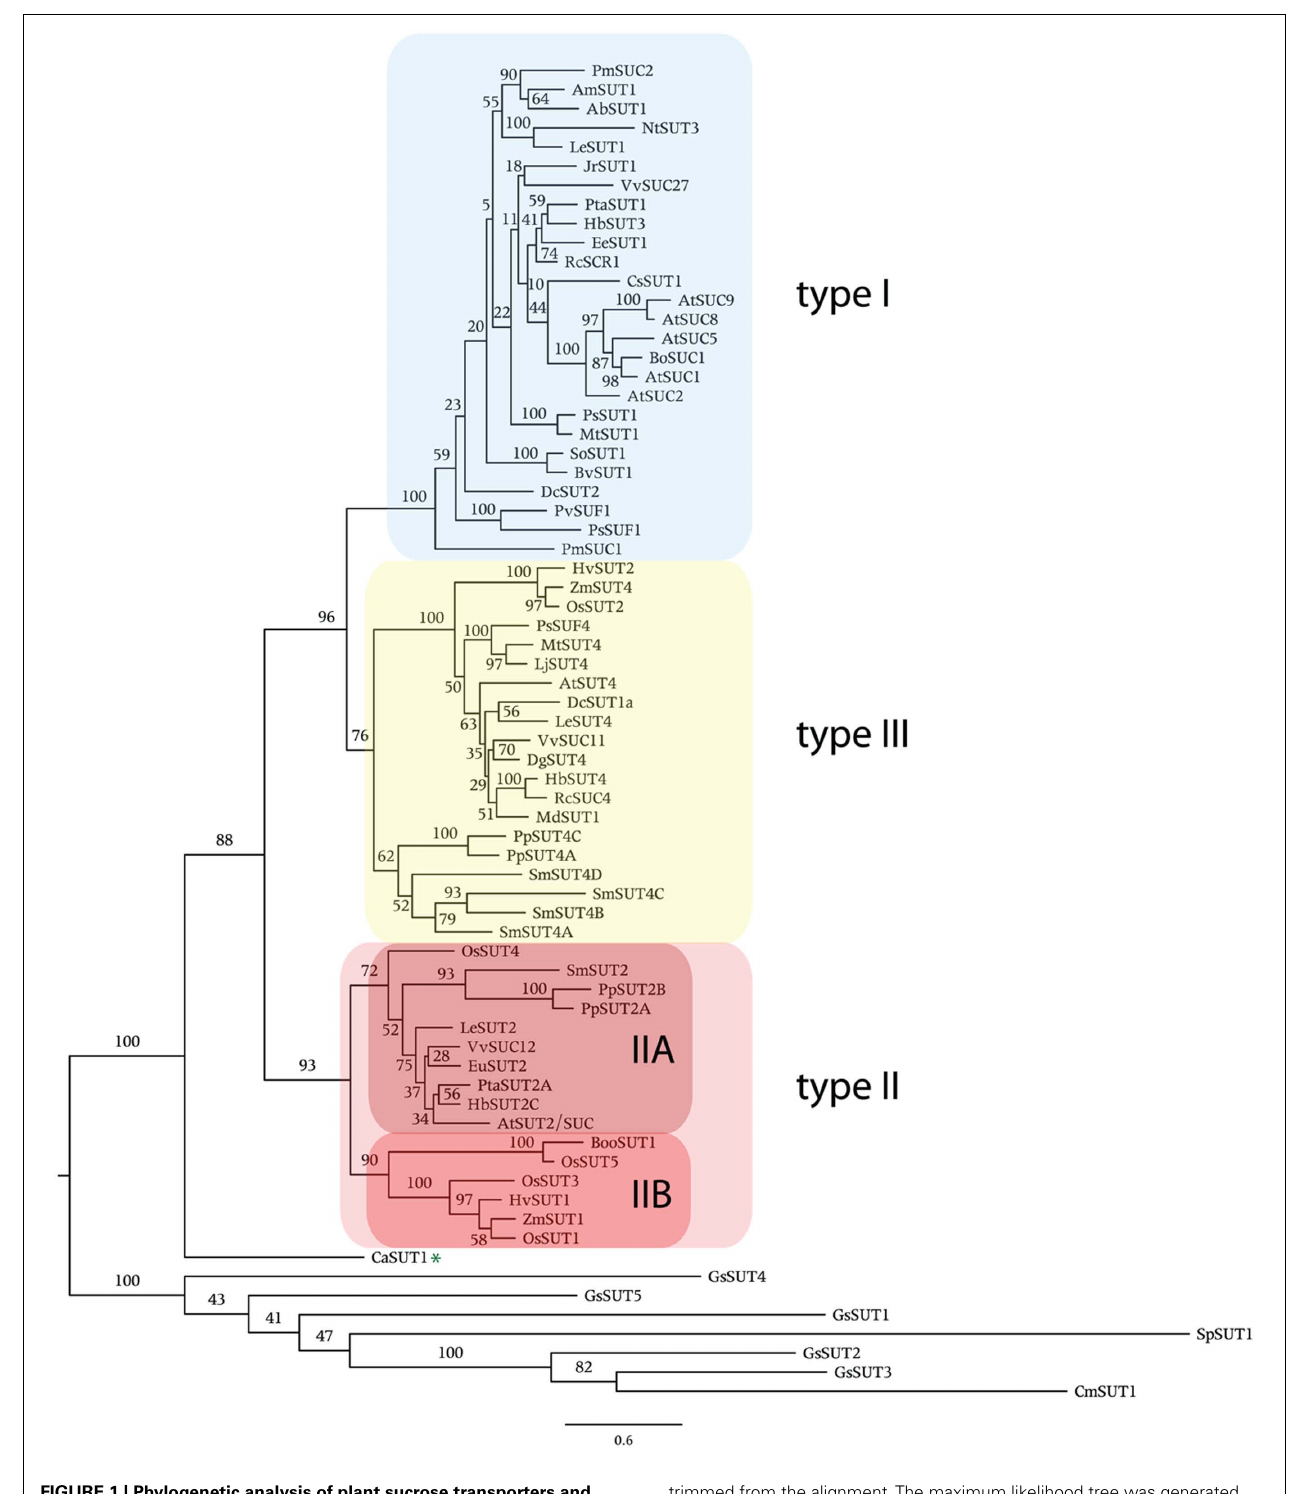
FIGURE 1 | Phylogenetic analysis of plant sucrose transporters and homologs. Protein alignment was done using Clustal X. Sequences with greater than 90% identity were not used in construction of the tree (they are shown in Table 1 ).The variable length N- and C-terminal regions were